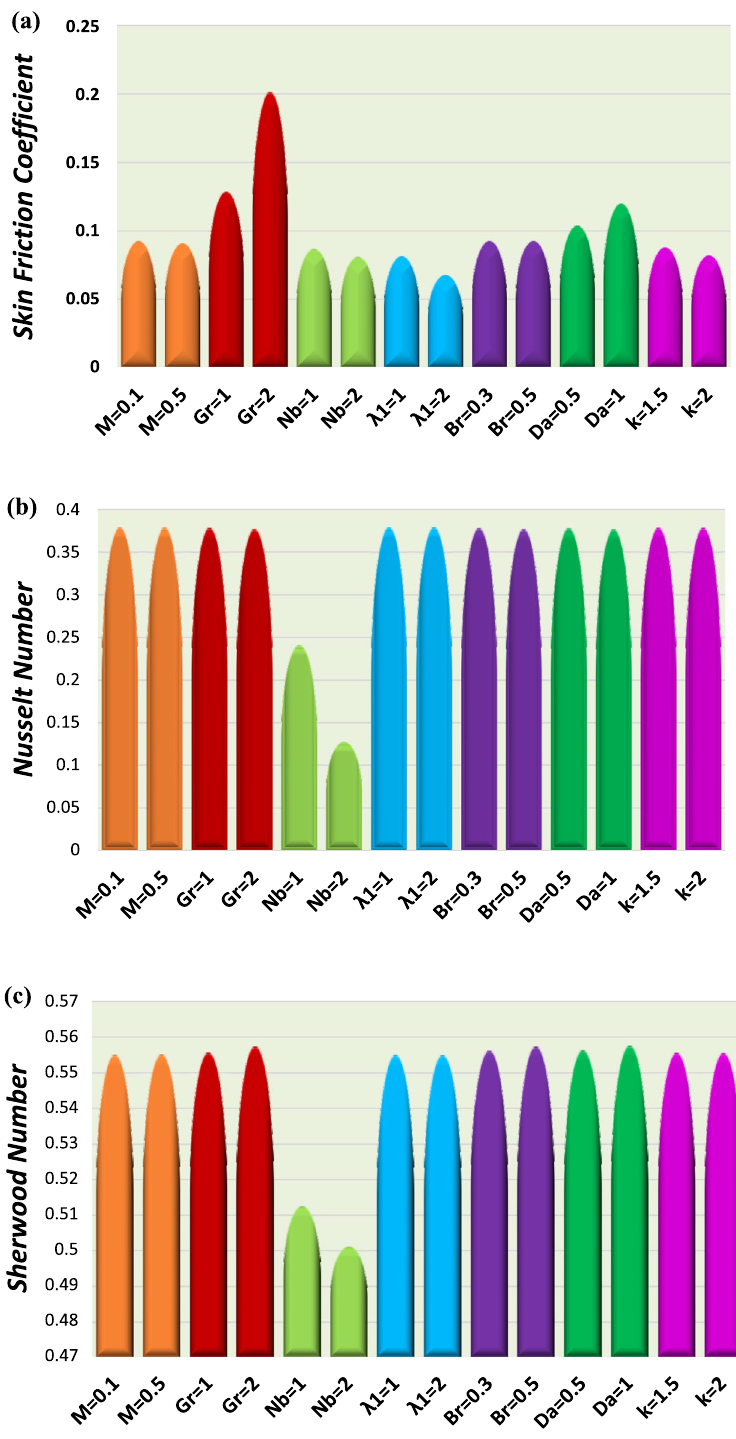
Figure 10. Discrepancy of the three quantities ( a ) the skin-friction coefficient. ( b ) Nusselt number. ( c ) Sherwood